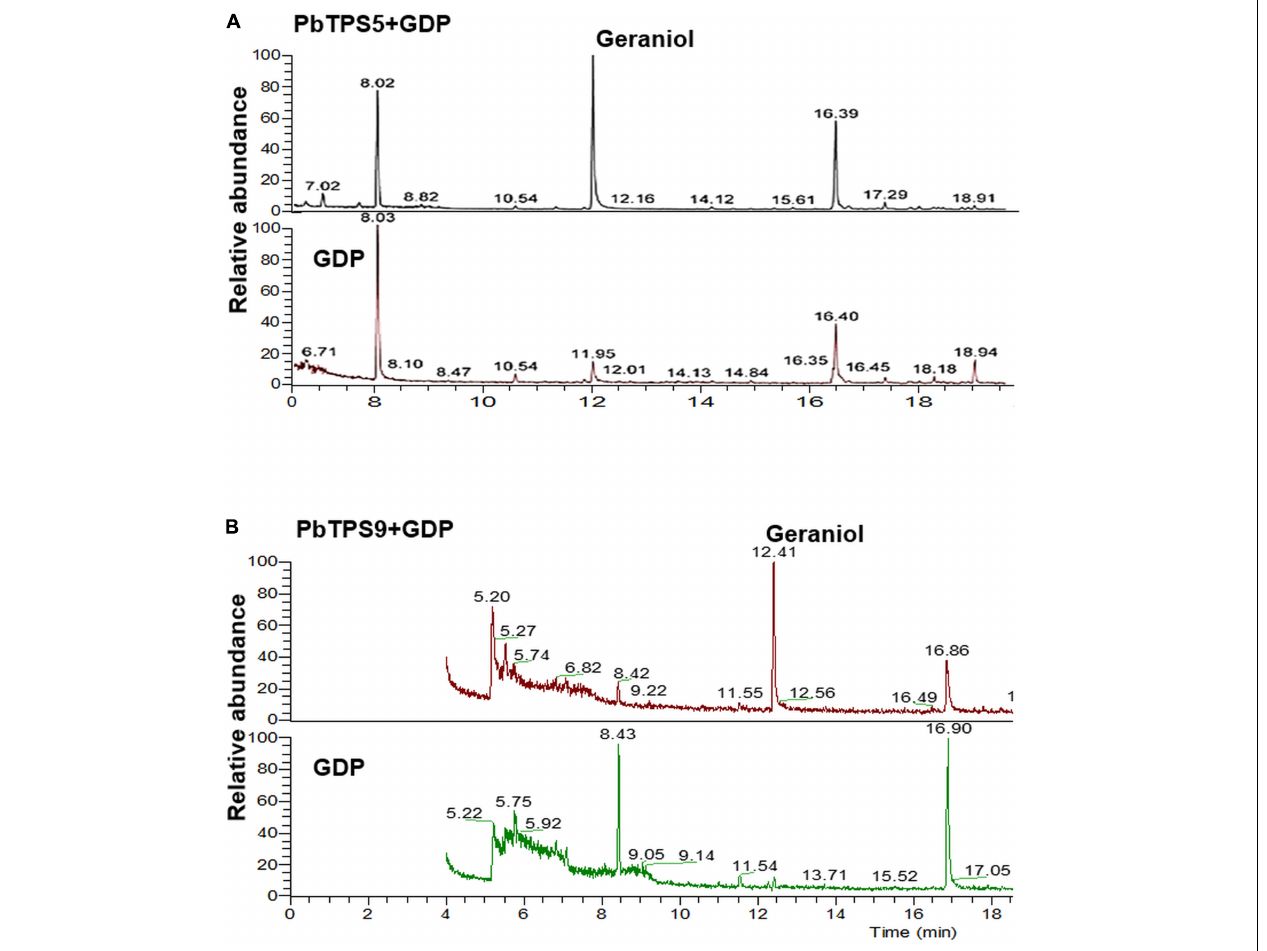
FIGURE 5 | Functional characterization of purified recombinant protein of (A) PbTPS5 + GDP and (B) PbTP9 + GDP. GC-MS analysis of authentic linalool standard incubated with enzyme assay buffer. As negative controls, reactions were performed with only GDP added without any recombinant